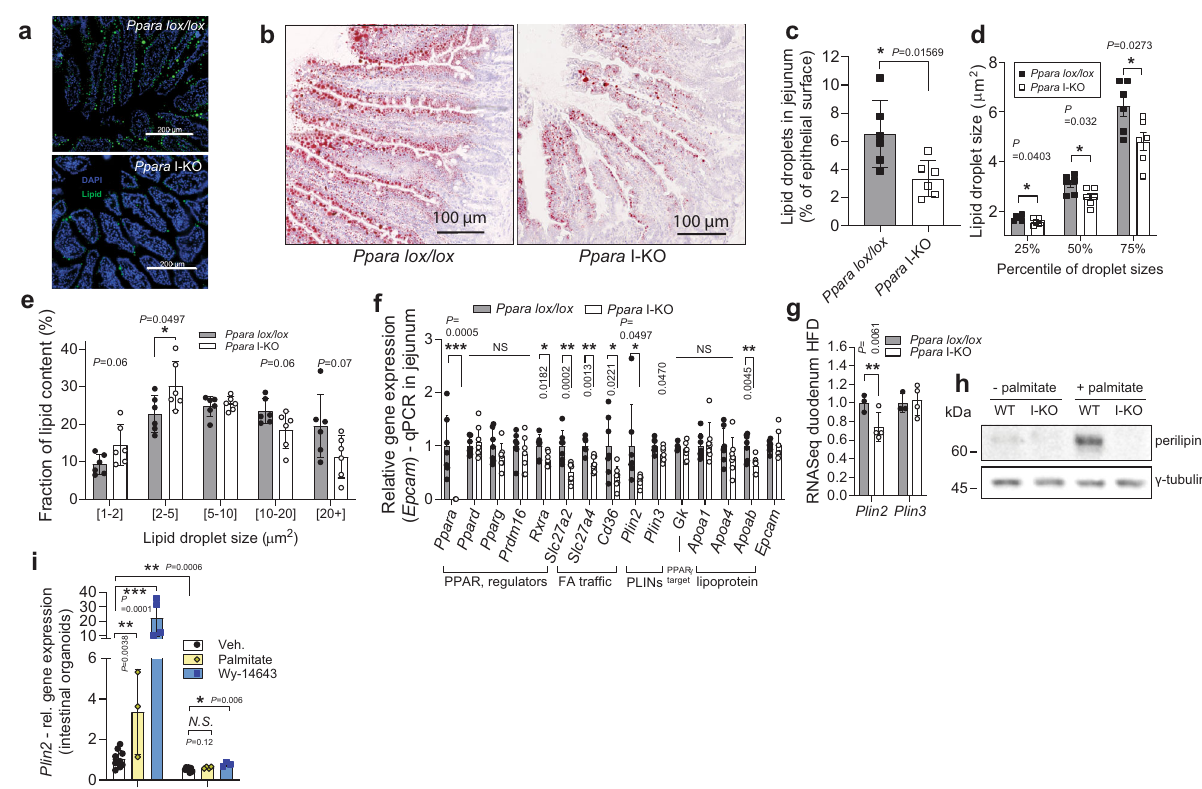
Fig. 6 PPAR α ablation reduces LD size and amount, and suppresses PLIN2 in small intestine. a Neutral lipids in cytosolic LDs in proximal jejunum stained green by LipidTOX, one hour after 100 μ l olive oil gavage. b Representative Oil red O staining of jejunum cryosection 1 h after olive oil gavage. c – e Cytosolic LD area as a percentage of total epithelial area ( c ), lipid droplet size distribution ( d ) and contribution of different cytosolic LD sizes toward total lipid area ( e ), quanti fi ed from Oil red O stainings of proximal jejuna, 1 h after olive oil load, n = 6 female mice per group (each sample is the average of three sections. f Relative qPCR gene expression, normalized to Tbp , in jejuna of fasted mice on HFD, n = 7 per group. g Relative RNA sequencing gene expression of Plin2 and three in duodenum of Ppara mice on HFD, n = 3 ( lox/lox ), four (I-KO mice). h Western blot against perilipin-2 in the organoids from Ppara lox/lox or I-KO, treated with 0.4 mM palmitate: BSA, or BSA. i Expression of Ppara target genes in the crypts as in ( h ), pool of two experiments, relative to lox/lox vehicle group, n = 7 for vehicle groups, 3 – 4 for treatments. All data represent mean ± S.D, * P ≤ 0.05, ** P < 0.01, *** P < 0.001 of